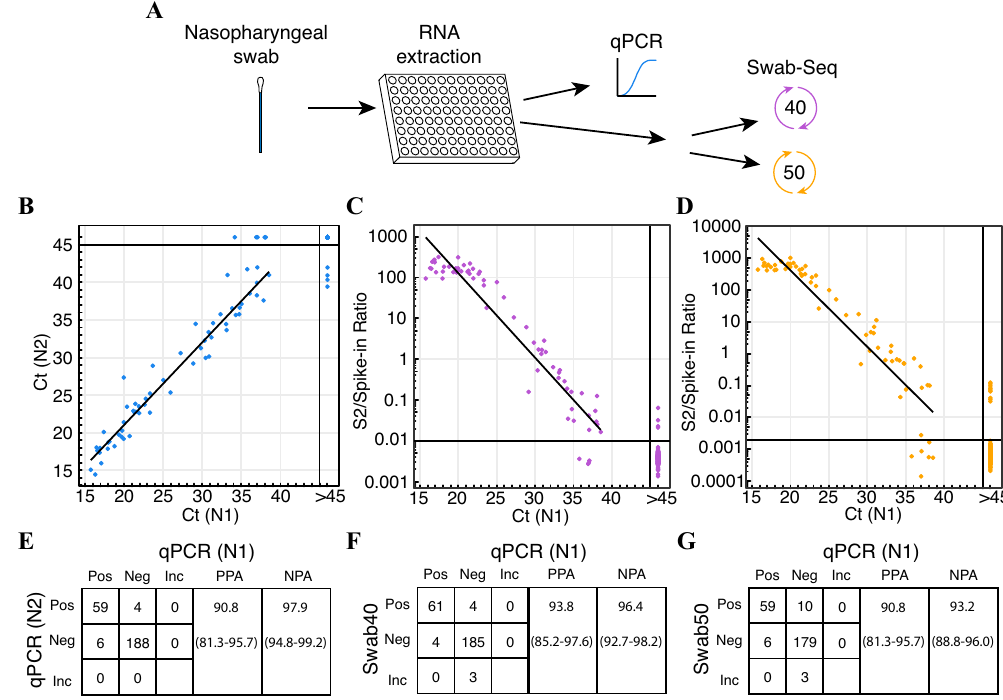
Figure 2. Evaluation of Swab-Seq as a community surveillance assay. ( A ) Schematic of testing regimen. After RNA extraction, all samples were tested via qRT-PCR, Swab-Seq with 40 cycles of amplification, or Swab-Seq with 50 cycles of amplification. ( B ) Ct values from qRT-PCR (average of triplicates) for N1 primer set (x-axis) are compared to Ct values from qRT-PCR (average of triplicates) for N2 primer set (y-axis). ( C ) Ct values (average of triplicates) for N1 primer set (x-axis) are compared to S2/Spike-in ratio for Swab-Seq with 40 cycles (y-axis). ( D ) Ct values (average of triplicates) for N1 primer set (x-axis) are compared to S2/Spike-in ratio for Swab-Seq with 50 cycles (y-axis). Black vertical lines partition “negative” from “positive” samples. Each dot is an individual sample. The diagonal lines are least-squares fitted lines incorporating all samples that are “positive” by both assays. ( E – G ) Tables of the number of samples categorized as positive or negative for the presence of the virus is presented between N1 qRT-PCR as the comparator assay and ( E ) N2 qRT-PCR, ( F ) Swab-Seq40, and ( G ) Swab-Seq50. Positive (“Pos”), negative (“Neg”), and inconclusive (“Inc”) results are compared pairwise. Positive % agreement (“PPA”) and negative % agreement (“NPA”) are provided for each comparison, along with 95% confidence intervals (in parentheses) calculated with the “Wilson” method from Ref. 25